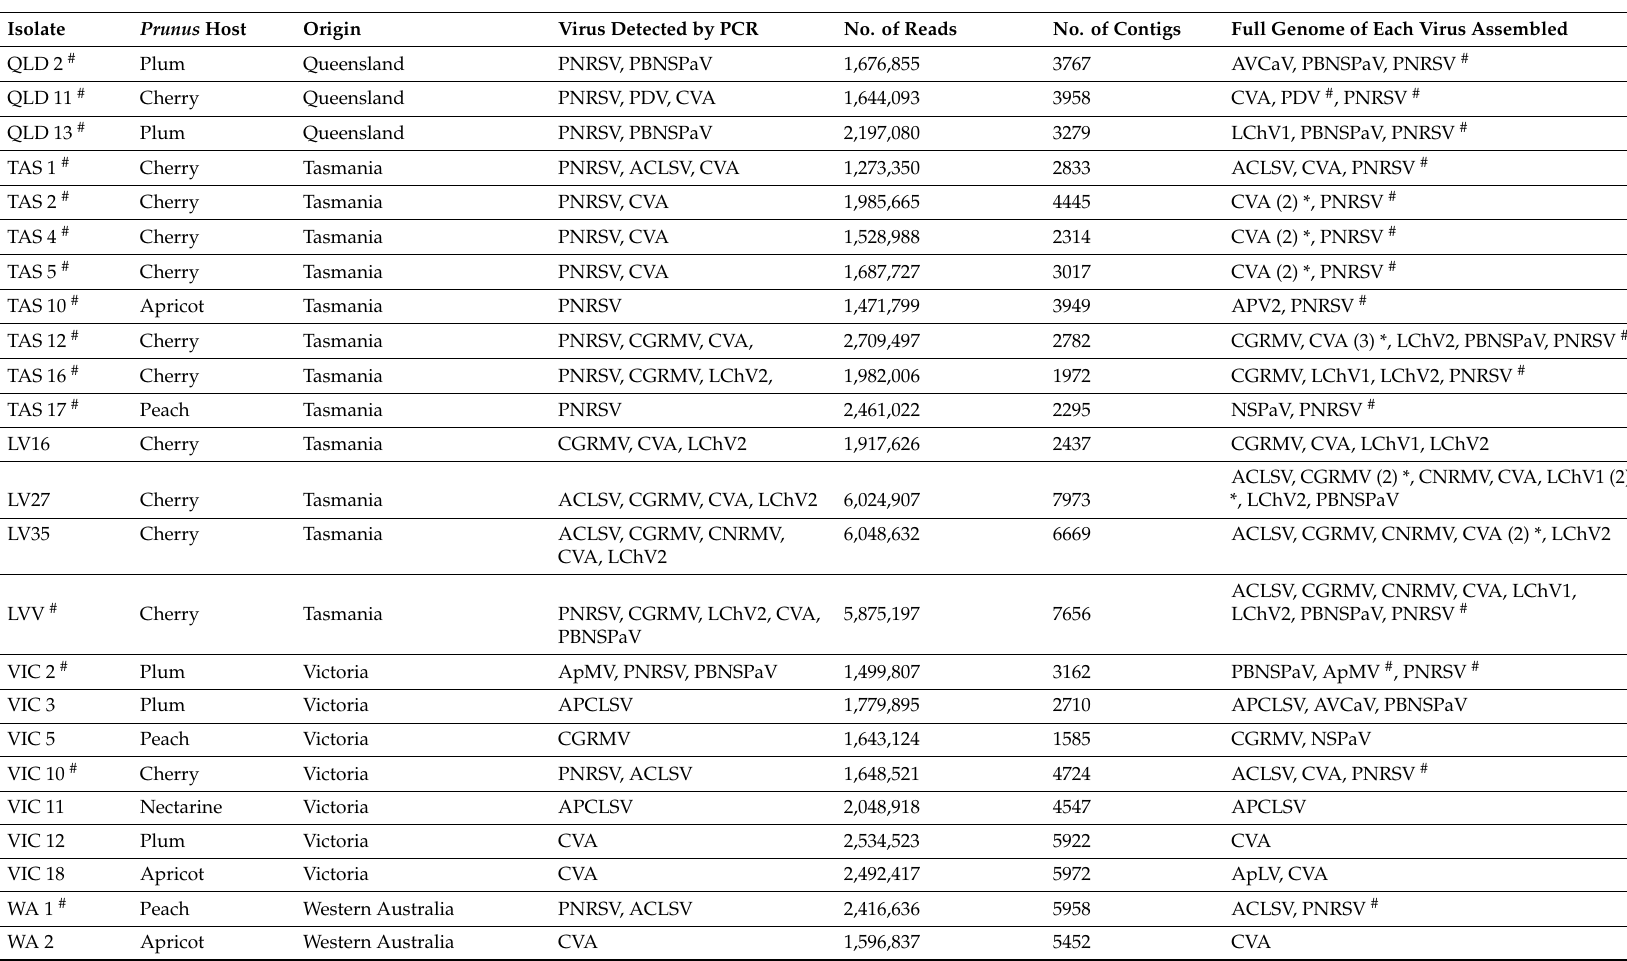
Table 4. High-throughput sequencing (HTS) data from 24 Prunus tree samples including the host species and origin, number of reads, the number of viral contigs and the full genome viruses identified from BLASTn analysis are